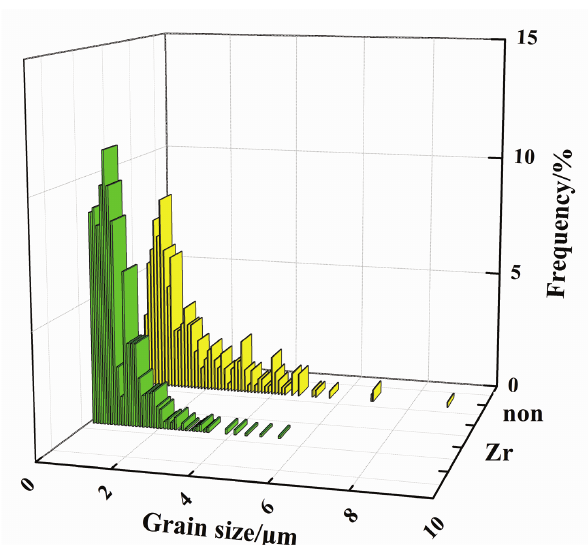
Figure 2: Grain size distribution of the ODS steels by EBSD analysis.